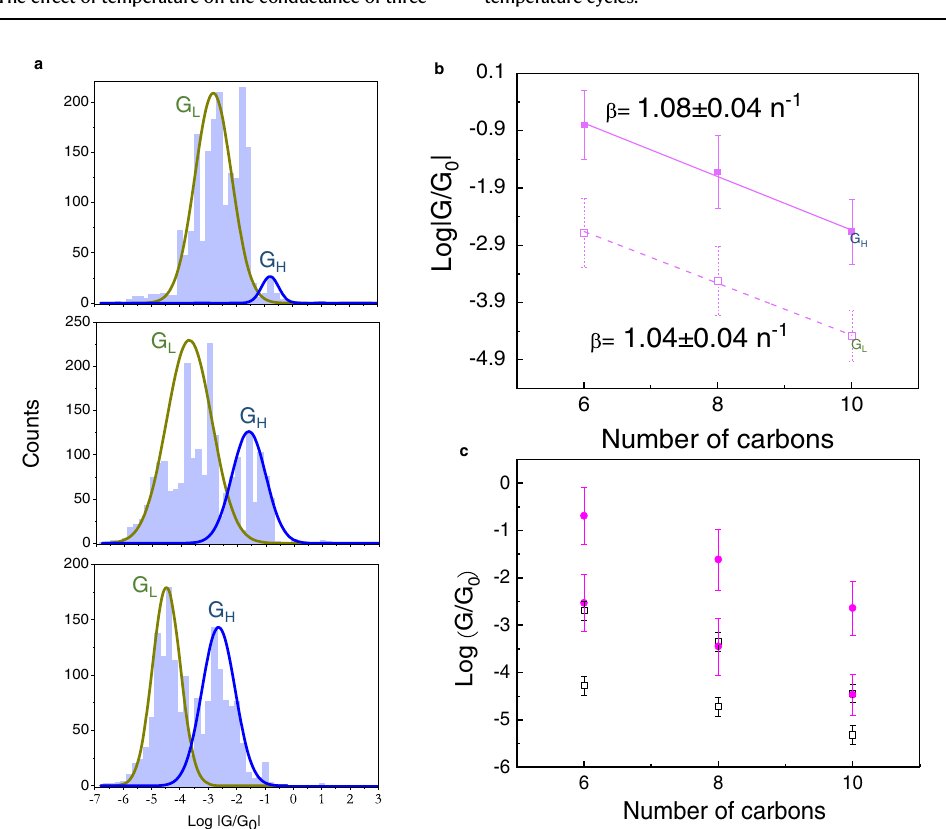
different C8 (magenta)and three different C10 (blue)junctions inthe temperature rangebetween8 – 300K.Thevariationbetweenjunctionscomplywiththevariation in conductance as presented in all other fi gures. The presented behavior for each junction was found to be highly reproducible under repeated measurements and temperature cycles.